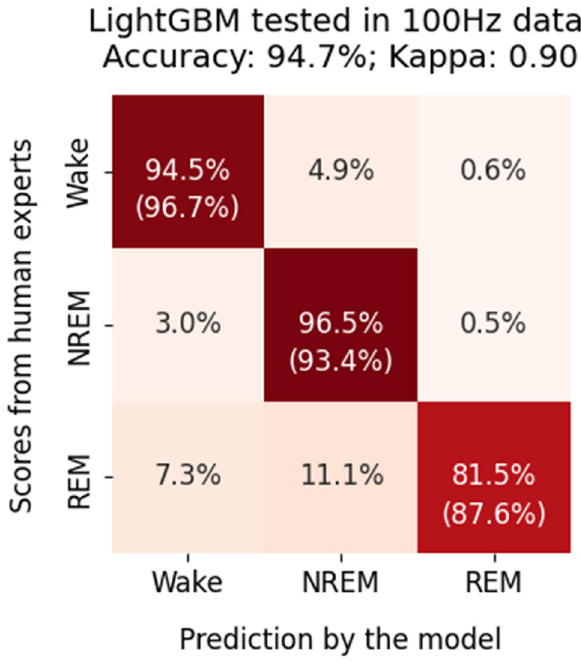
Figure 6. The performance of the LightGBM model when signals were downsampled to 100 Hz. The numbers without parentheses in the heatmaps indicate the percentage of the scores from human experts (ground truth) that are in agreement with the scores generated by the model. The numbers inside parentheses indicate the percentage of model-generated scores that are in agreement with the scores of the human experts. Therefore, in the left–right diagonal line, the numbers without parentheses indicate recall, and the numbers inside parentheses indicate